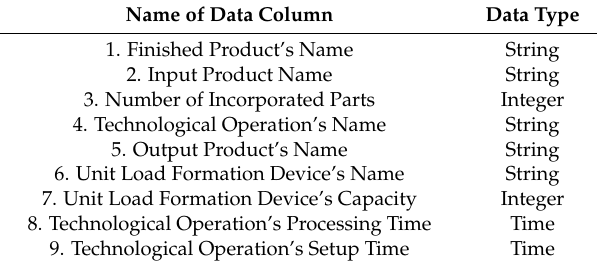
Table 2. Structure of the manufacturing data table.